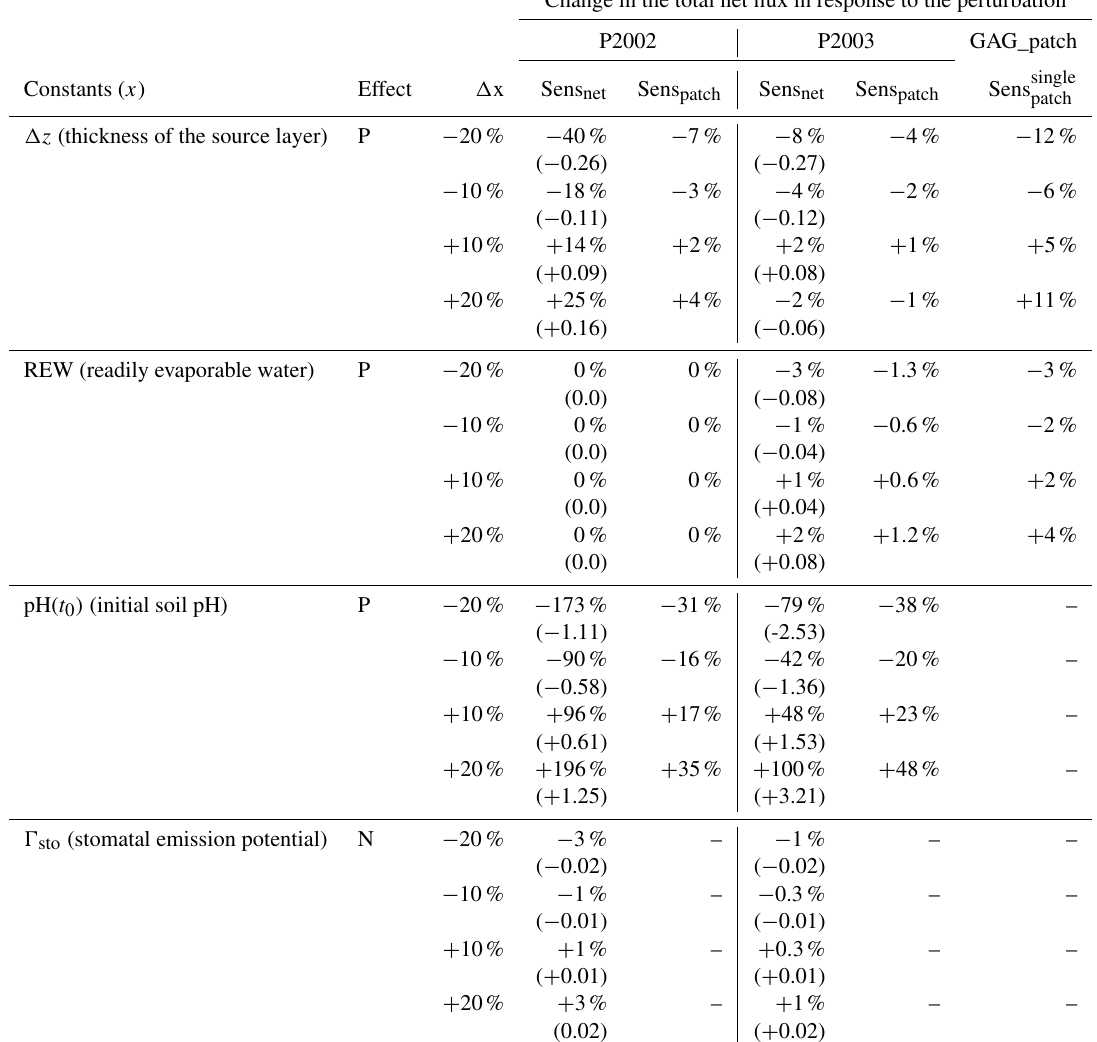
Table 3. Results of the perturbation experiments with GAG_ field. The changes in the total NH 3 flux over the field as a response to a change ( ± 10 and ± 20%) in the listed model parameters where expressed as the percentage of the total NH 3 exchange in the baseline simulations with GAG_field and in the brackets as the hourly change in the total net exchange over the whole field (gNh − 1 ) . Results are listed for both modelling periods, P2002 and P2003, separately for the whole field (Sens net ) and the urine patches (Sens patch ) . As a comparison, the results ) . In the column “Effect” the letters of the sensitivity analysis carried out by Móring et al. (2016) for GAG_patch are also indicated (Sens single patch denote how the given parameters affect total NH 3 exchange in GAG_field: through the urine patches (P) or the non-urine area (N) or